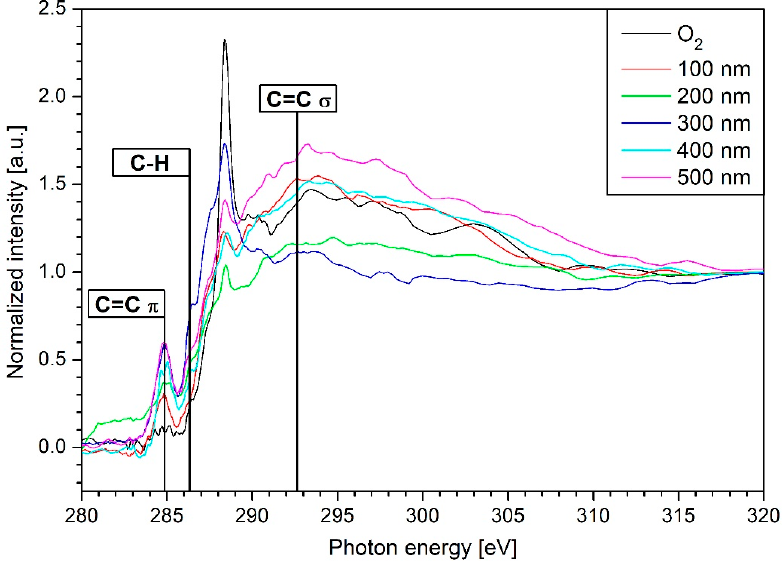
Figure 5. NEXAFS spectra of selected a-C:H layer thicknesses on PHB. Black is the reference sample, red a coating of 100 nm, green 200 nm, dark blue 300 nm, pale blue 400 nm and magenta 500 nm.